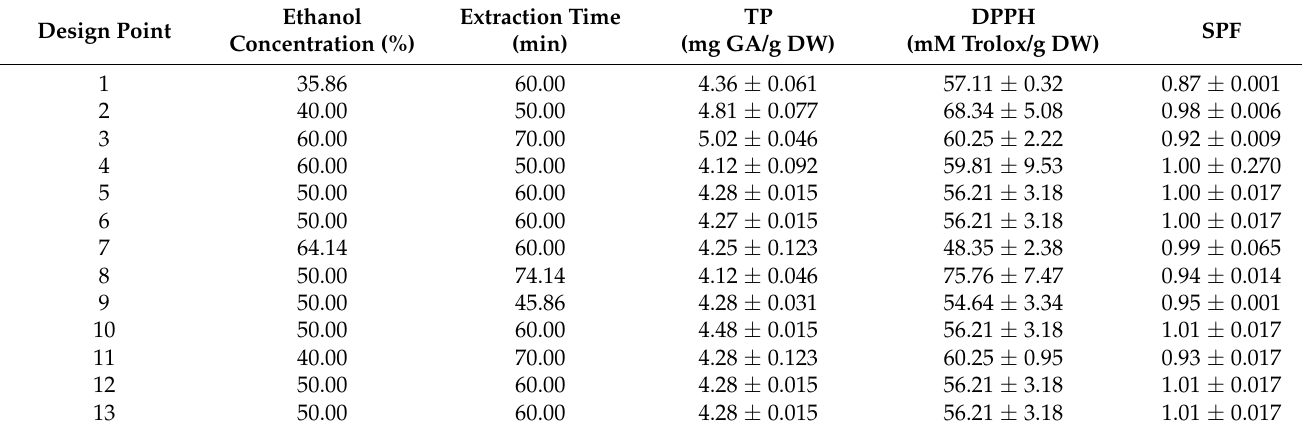
Table 2. Experimental values of TP, DPPH and SPF for apple extracts obtained by refluxing and measured at design